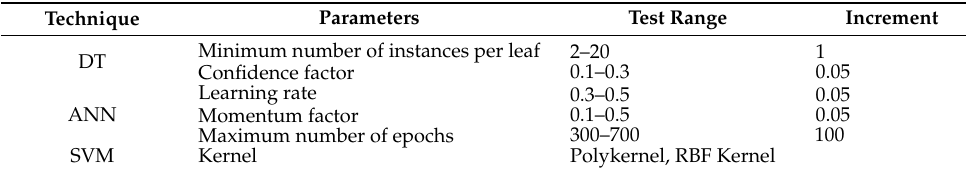
Table 2. Parameter